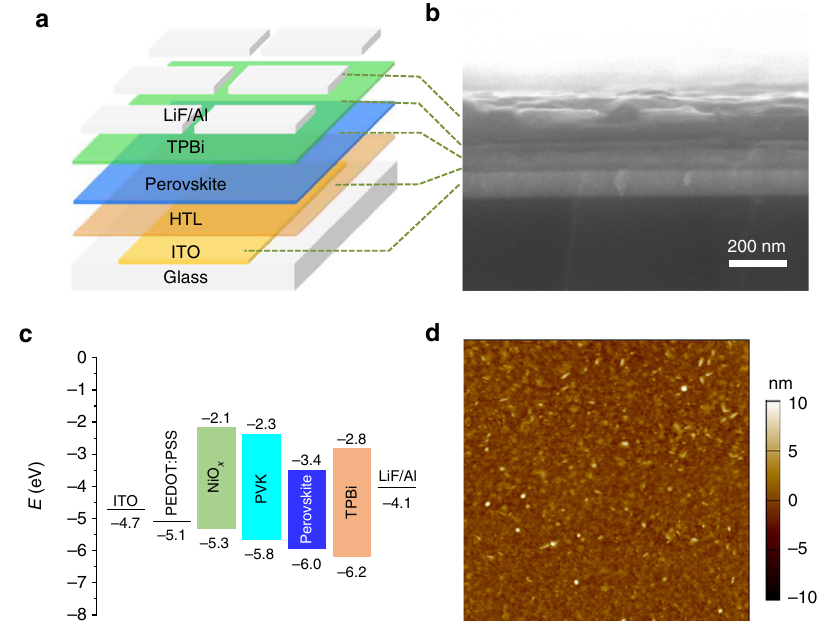
Fig. 3 Device structure of PeLEDs. a Device structure, b cross-sectional SEM image and c energy level alignment of the PeLEDs, showing conduction and valence-band levels with respect to vacuum. The energy level of perovskite layer was determined by UPS measurement. d AFM image of perovskite fi lm on PEDOT:PSS. Scan area is 5 × 5 μ m 2 . The surface roughness was measured to be around 1.0